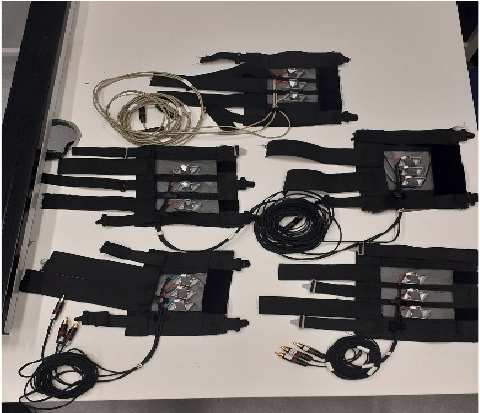
Figure 3. The five vibrotactile sleeves with different interspacings between actuators that were used in the